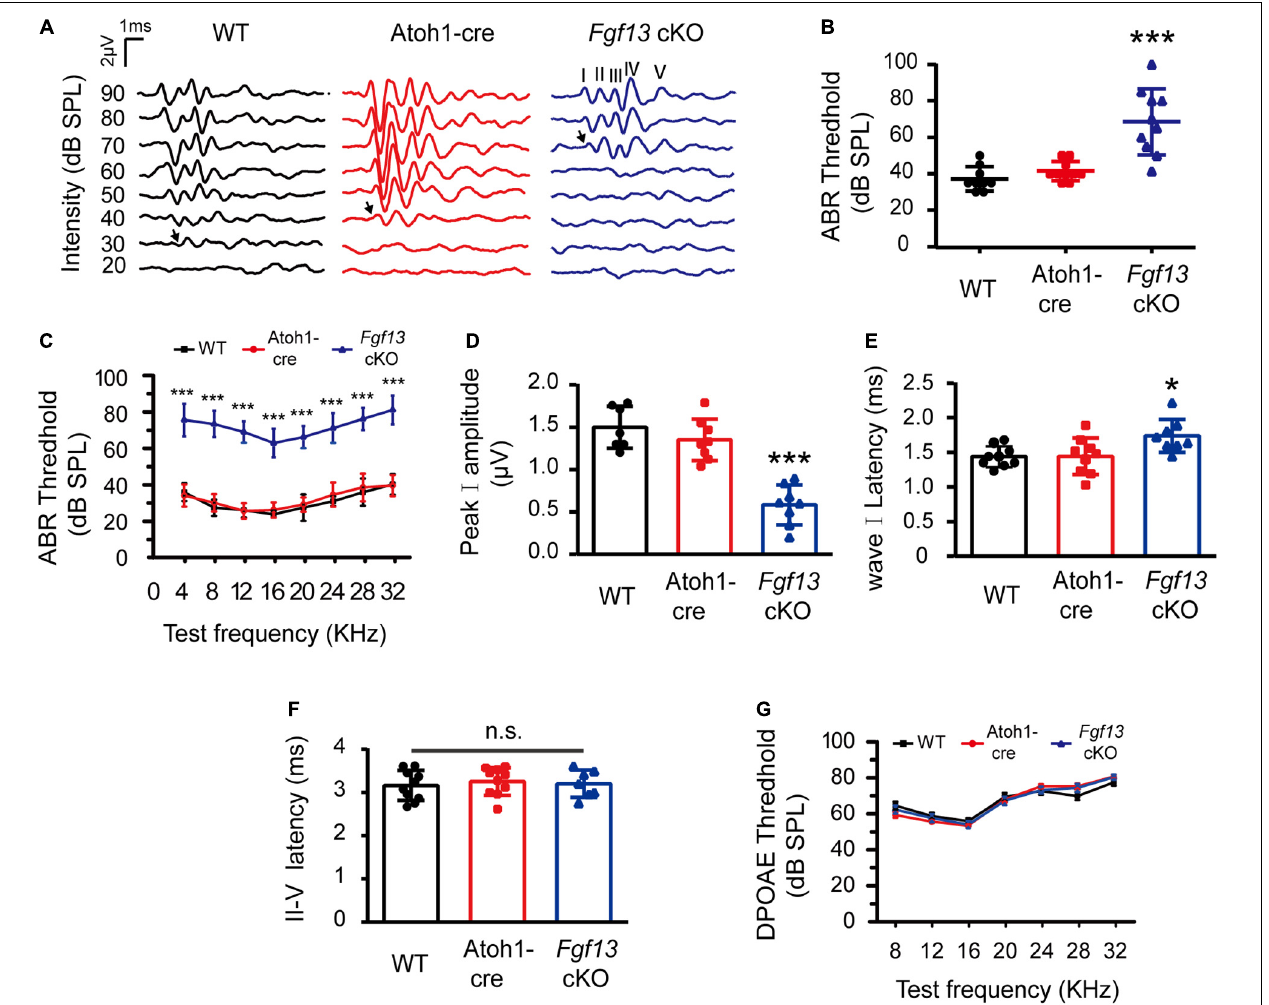
FIGURE 3 | Fgf13 cKO mice exhibit sensorineural hearing loss. (A) A representative click-evoked ABR waveform at decreasing intensities from 90 to 20 dB SPL in WT, Atoh1-cre and Fgf13 cKO mice. Arrows indicate threshold levels. (B,C) ABR measurements for click (B) and tone burst responses (C) . n = 9/WT (5 M, 4 F); n = 10/Atoh1-cre (6 M, 4 F); n = 10/ Fgf13 cKO (7 M, 3 F). (D–F) The peak I amplitude (D) , latency of wave I (E) , and II-V (F) in ABR test were analyzed. The traces analyzed in (D–F) were from click test at SPL of 80 dB. n = 7/WT (5 M, 2 F); n = 8/Atoh1-cre and Fgf13 cKO (5 M, 3 F) in peak I amplitude. n = 9/WT and Atoh1-cre (5 M, 4 F); n = 8/ Fgf13 cKO (5 M, 3 F) in wave I latency. n = 10/WT and Atoh1-cre (6 M, 4 F); n = 7/ Fgf13 cKO (5 F, 2 M) in II-V wave latency. * P < 0.05, *** P < 0.001 compared to controls as determined by One-Way ANOVA test. (G) DPOAE measurements in WT, Atoh1-cre and Fgf13 cKO mice. n = 10/ WT (6 F, 4 M); n = 9/Atoh1-cre (5 M, 4 F); n = 4/ Fgf13 cKO (3 M, 1 F). F, female; M, male; n.s., no significance. P > 0.05 as determined by One-Way ANOVA